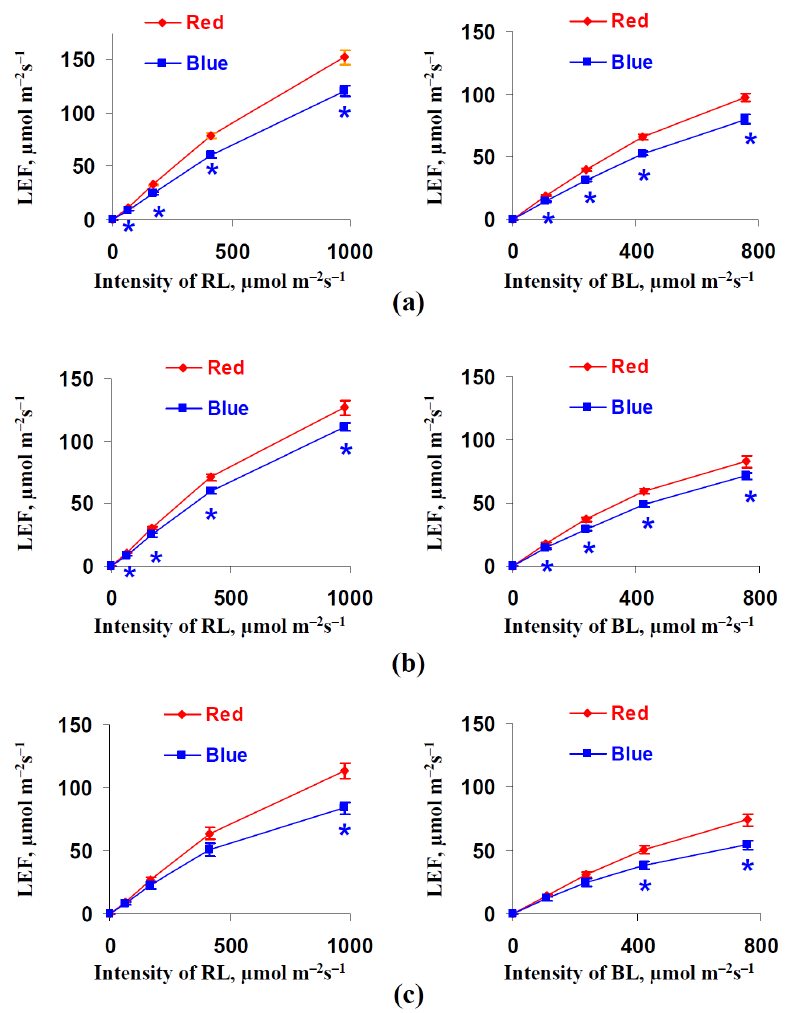
Figure 6. Dependences of the linear electron flow (LEF) on the intensity of the red actinic light (RL) (left panels) and blue actinic light (BL) (right panels) after 18 ( a ), 25 ( b ), and 32 ( c ) days of lettuce cultivation under the red (marked as “Red”) and blue (marked as “Blue”) illumination variants (see Figure 1) ( n = 5–7). * differences between plants cultivated under the red and blue variants of illumination were significant ( p < 0.05).